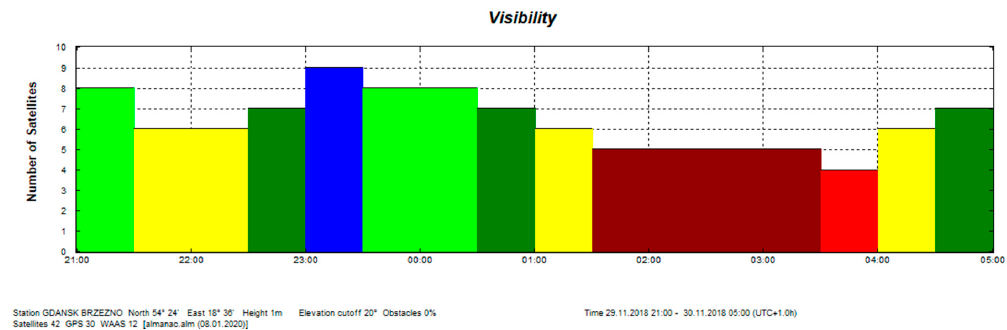
Figure 19. GPS satellite visibility on 28,29 November 2018. (Source : Trimble Planning 2.9, 2010.) The presented test was started at 2200 UTC with the visibility of six GPS satellites (Figure 19).